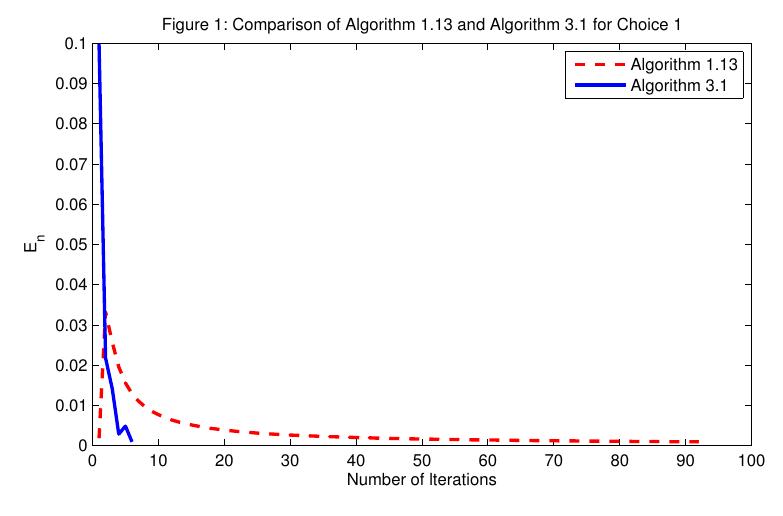
Algorithm 1.13 Algorithm 3.1